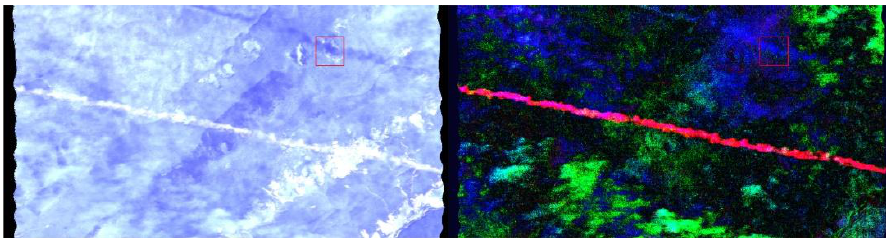
Figure 8. Left image shows a false color image highlighting the AIC shadow on the ground. Right image shows a false color composite representing cloud coverage.